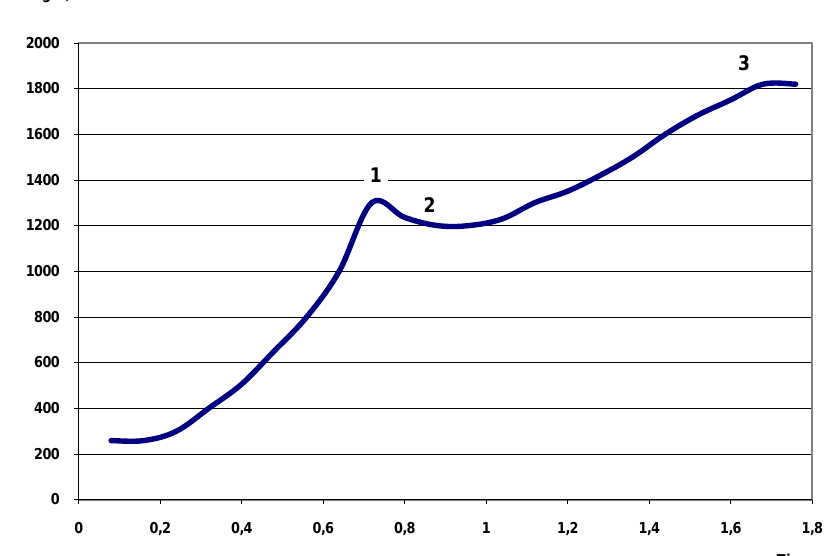
Diagram 5. Results of snatch with weight 65% from maximal. Figures mark main